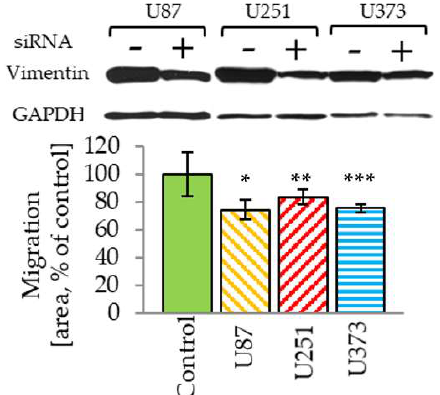
Figure 4. siRNA vimentin downregulation reduces the ability of cells to migrate across a transwell membrane in the modified Boyden chamber assay at 24 h post-transfection. The number of cells measured on the bottom side of membrane was normalized to the performance of the respective scrambled siRNA control (=100%) for each cell line; * p = 0.010, ** p = 0.015, *** p = 0.037. Western blot (upper) shows the actual degree of vimentin downregulation obtained for each cell line compared with scrambled siRNA control.